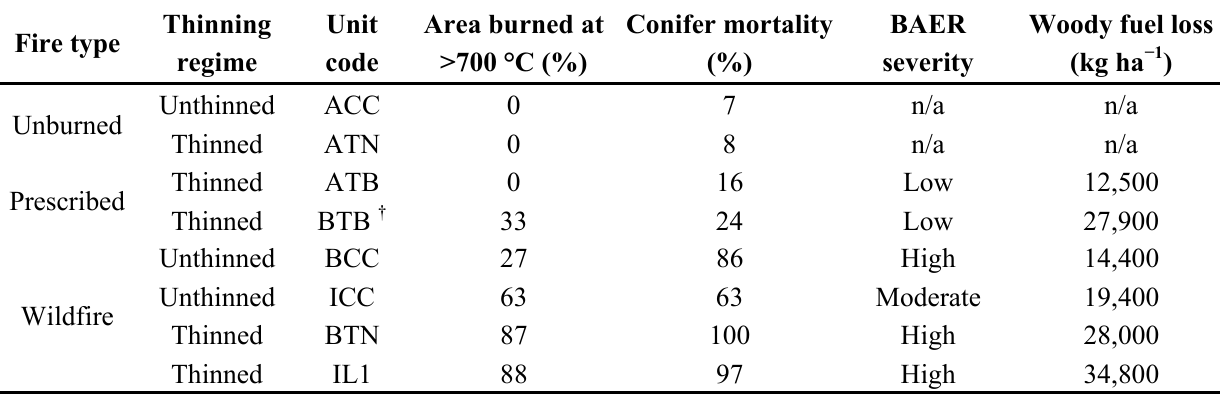
Table 2. Siskiyou LTEP experimental units that were evaluated for soil charcoal. The % of area burned at >700 ° C and conifer mortality are expanded from Bormann et al. [22]. BAER burn severity ratings are from Azuma et al . [45]. Minimum mapped BAER polygon was 50 acres whereas treatment areas are 10 to 15 acres [45]. Losses of woody fuels (>1 cm diameter) due to fire are from Homann et al.